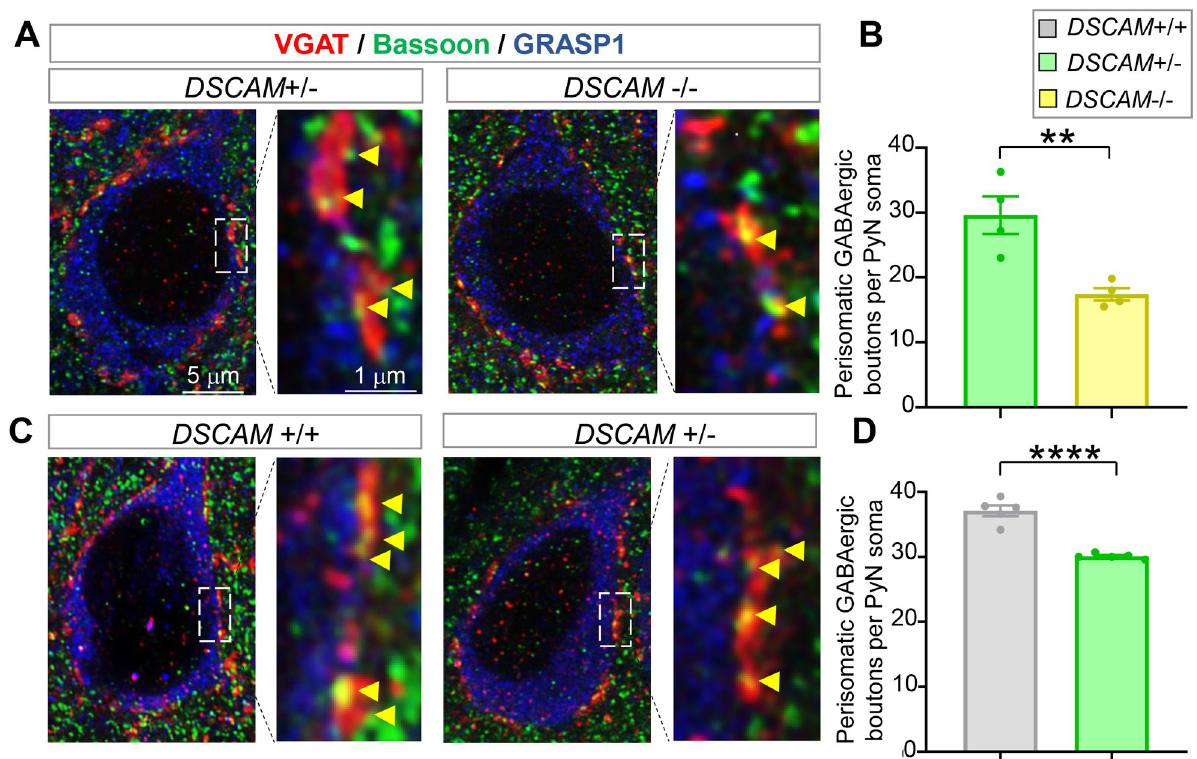
Fig 4. Loss of DSCAM impairs the perisomatic GABAergic boutons innervating PyNs in layer II/III of the ACC. ( A and C ) Representative images of perisomatic GABAergic boutons innervating PyNs of DSCAM 2j/+ (+/ − ) and DSCAM 2j/2j ( − / − ) mice ( A ) as well as those of DSCAM +/+ (+/+) and DSCAM 2j/+ (+/ − ) mice ( C ). ( B and D ) Quantifications. Each data point in the chart represents the mean in 1 mouse. Student t test. ** : p < 0.01; **** : p < 0.0001. The data underlying this Figure can be found in https://doi.org/10.5281/zenodo.7714234. ACC, anterior cingulate cortex; DSCAM, Down syndrome cell adhesion molecule; PyN, pyramidal neuron.